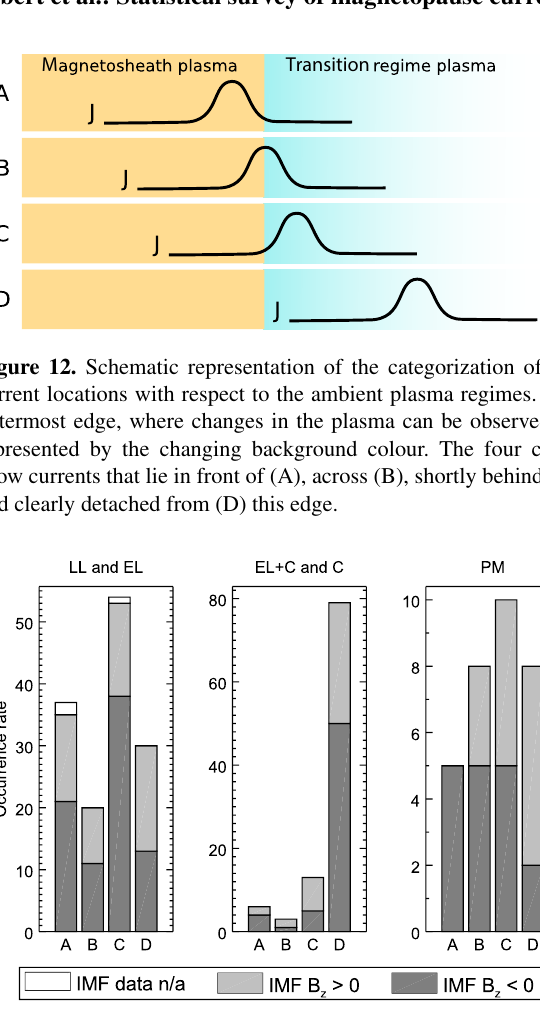
Figure 13. Occurrence rate of the current locations for the different transition regions as described in the text and by Fig.